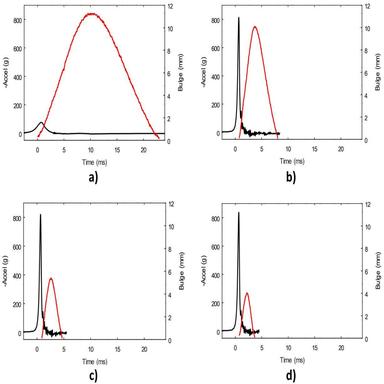
Time delay between peaks of deceleration (in black) and bulge (in red) for the four gels tested. The time delays were a) 9.50 ms for 527 (1:1) with an impact velocity of 0.83 m/s, b) 3.70 ms for 3–6636 (1:2) with an impact velocity of 2.40 m/s, c) 2.60 ms for 184 (37:1) with an impact velocity of 2.31 m/s, and d) 2.15 ms for 184 (33:1) with an impact velocity of 2.32 m/s.